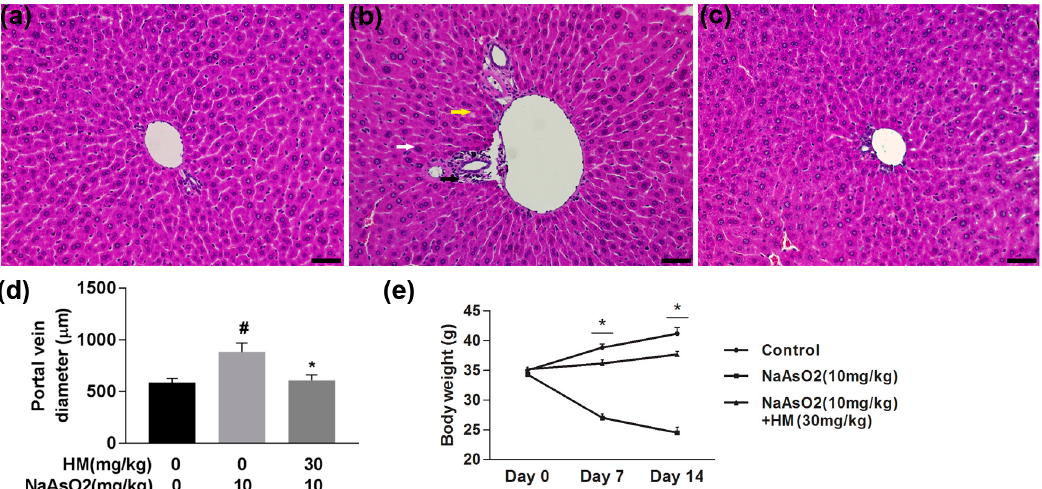
Figure 3. HM improved the liver histology and body weight in experimental mice. Untreated mice were used as a control to compare histological changes induced by NaAsO 2 . ( a ) Normal control; ( b ) NaAsO 2 (10 mg/kg); ( c ) Co-treatment with HM (30 mg/kg) + NaAsO 2 (10 mg/kg); ( d ) portal vein diameter; and ( e ) Body weight. In the NaAsO 2 group, the white arrow indicates the degenerative nucleus, the yellow arrow indicates the blurred cytoplasm and the black arrow indicates the damaged hepatic lobule surrounding hepatic artery. In contrast, co-treatment with HM improved histological changes compared to NaAsO 2 alone. Portal vein diameter and body weight also significantly decreases and increased in HM-treated mice, respectively. Data are expressed as mean ± standard error mean (SEM) of three independent experiments. Scale bar: 200 μ M. # p < 0.05 compared with the control and NaAsO 2 group, and * p < 0.05 compared with the NaAsO 2 and HM extract-treated group. Figure 4. Effect of HM on serum markers and lipid peroxidation in experimental mice. ( a ) Serum alanine aminotransferase (ALT), ( b ) serum aspartate aminotransferase (AST), and ( c ) Malondialdehyde (MDA) levels in liver tissue. ALT, AST and MDA levels were increased in NaAsO 2 -intoxicated mice. Co-treatment with HM significantly decreased the serum ALT and AST and tissue MDA levels as compared to NaAsO 2 alone. Data are expressed as mean ± standard error mean (SEM) of three independent experiments. # p< 0.05 compared with the control and NaAsO 2 group, and * p < 0.05 compared with the NaAsO 2 and HM extract-treated group.